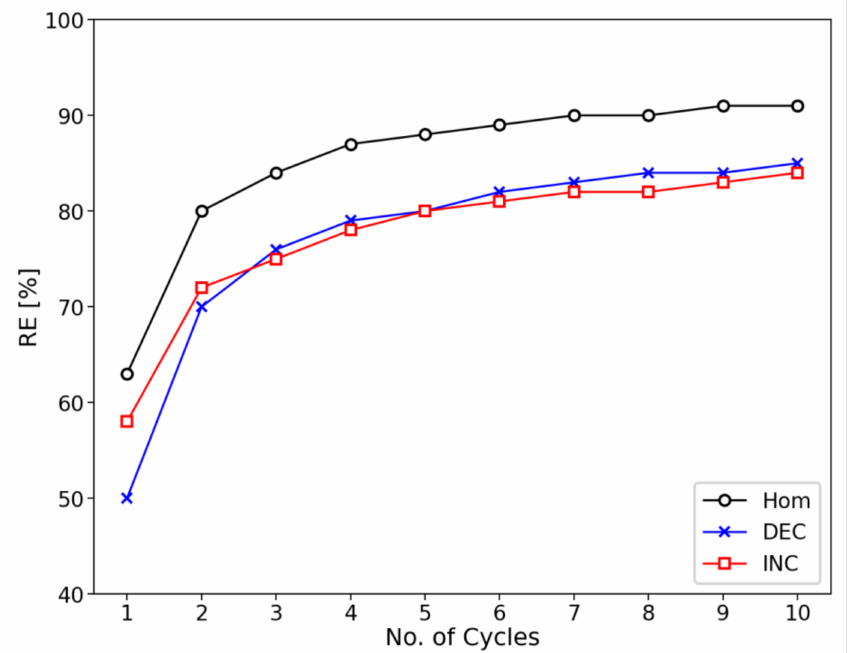
Figure 7. RE values calculated for ten ASR cycles for the homogenous (‘Hom’) and two heterogenous cases (‘DEC’ and